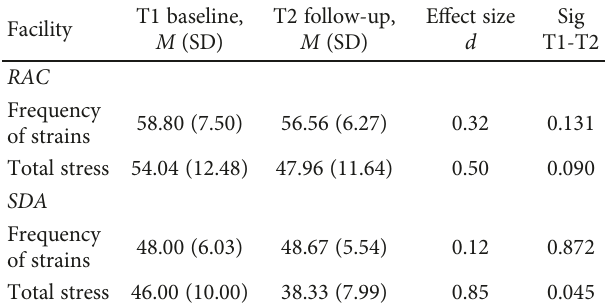
Table 4: Means, standard deviations, and e ff ect sizes on the SDCS.